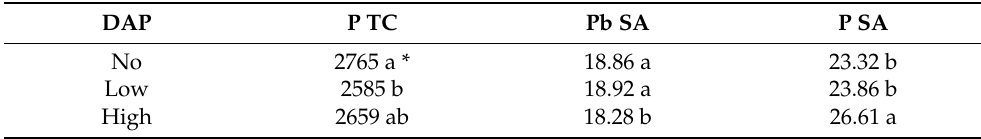
Table 6. Mean P tissue concentration (P TC in ug g − 1 ), soil available Pb (Pb SA), and soil available P (P SA) obtained from the three levels of DAP showing the main effect of DAP.